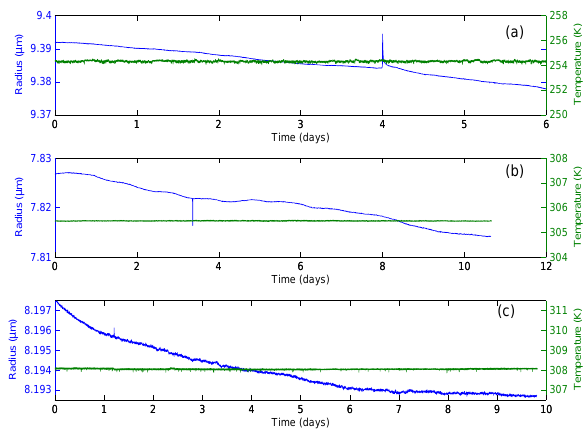
Fig. A1. Radius data from (a) 2-methylglutaric acid, (b) DL-tartaric acid and (c) citric acid. Note that (a) and (b) have coarse radius range (30 and 20nm, respectively) while (c) has a range of 5nm. The spike in panel (a) near day four is an instrumental artifact and 2 was excluded from the fit of d r . Panel (c) appears to show an expo- d t nential decrease that is consistent with an exceedingly slow loss of water. The evaporative loss of citric acid in panel (c) must be lower than the loss rate of water after 10 days of drying at 35 ◦